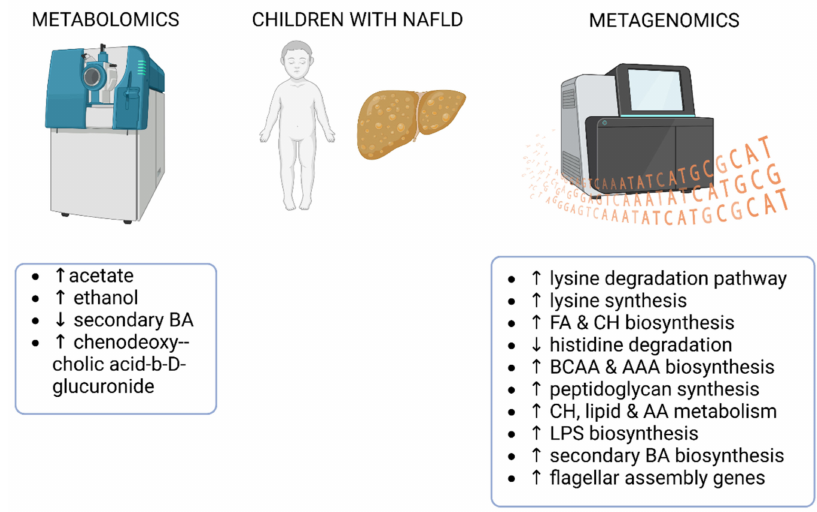
Figure 4. Main findings from studies reporting fecal metagenomics and/or metabolomics in children with NAFLD. FA—fatty acids; CH—carbohydrates; BA—bile acids; AA—amino acids, BCAA— branched chain amino acids; AAA—aromatic amino acids; LPS-lipopolysaccharides. The figure was created using BioRender. Table 1. The reviewed studies presenting metabolomic and/or metagenomic findings regarding the human gut microbiota and